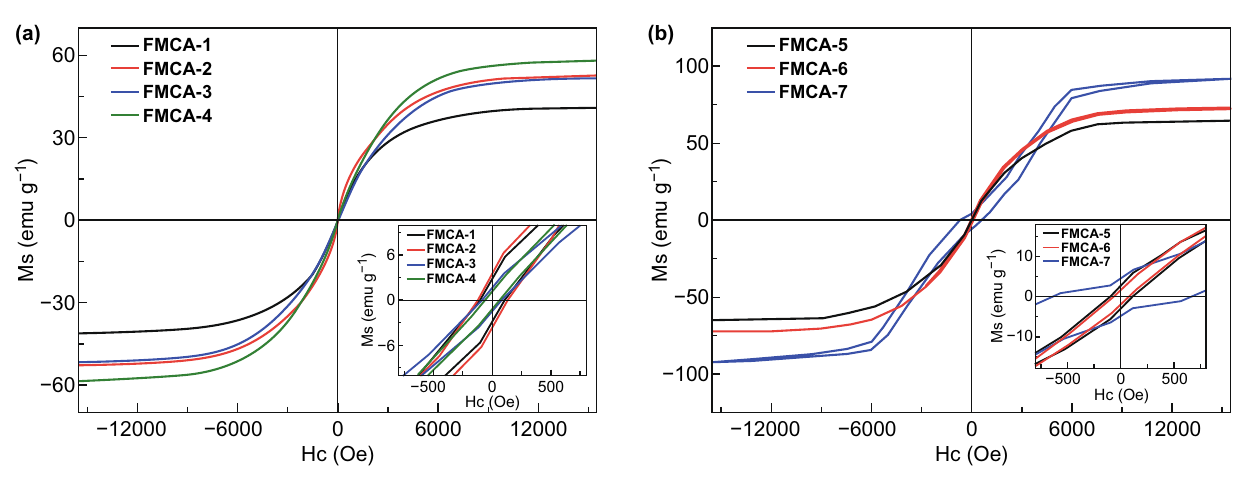
Fig. 5 a , b Magnetization hysteresis loops at 300 K and insert is the corresponding magnification around the